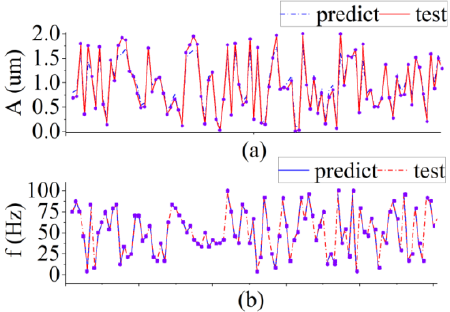
Figure 5. Prediction of A and f in the simulation test. ( a ) Measurement of A in the range of 0~2 µm. ( b ) Measurement of f in the range of 0~100 Hz.